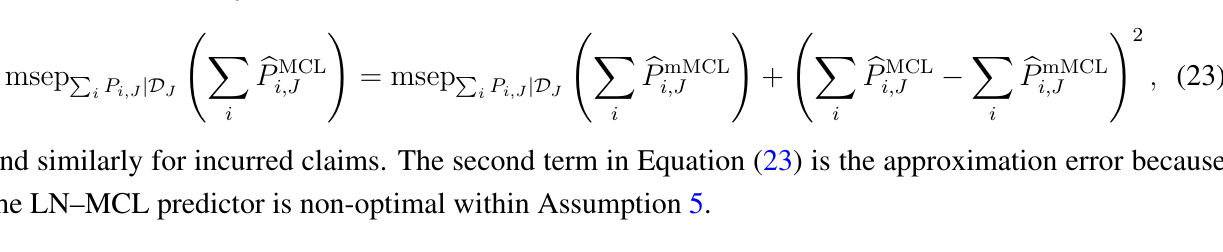
Table 3. Resulting reserves and square-rooted conditional mean square error of prediction of the different chain-ladder methods. ∗ is calculated from Equation